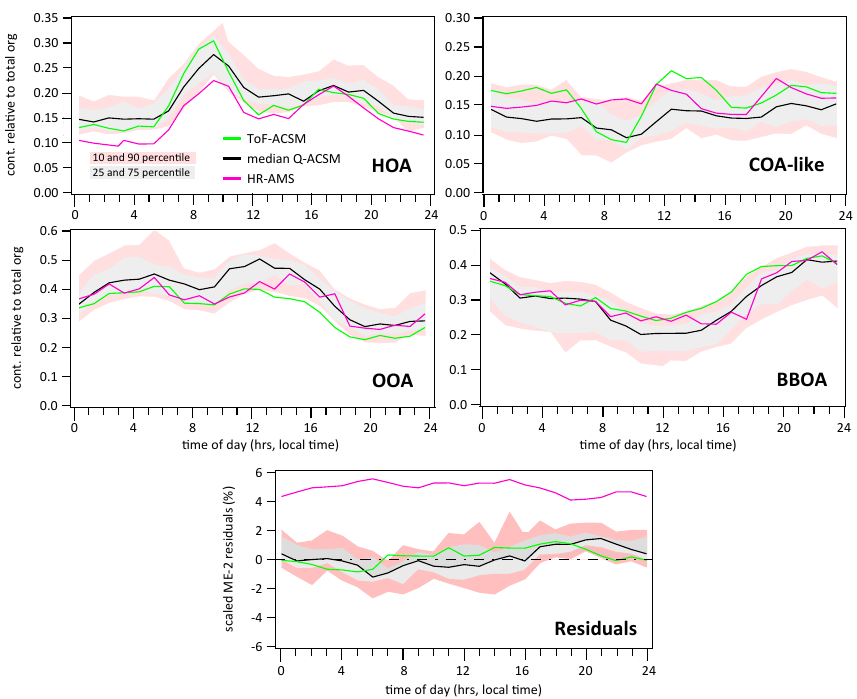
Figure 5. Diurnal variation of the four source factors and PMF residuals. The upper four panels display the relative contribution of the respective sources to the total apportioned organic matter. Top left: HOA, top right: COA-like, bottom left: OOA, bottom right: BBOA. Green trace: ToF-ACSM, pink trace: HR-ToF-AMS, black trace: median of all 13 Q-ACSMs. The IQR and the 10–90 percentile range of the Q-ACSMs are indicated as light grey and light red regions, respectively. The lower panel shows the residual organic concentration not explained by the presented solution in % of the total organic concentration. The time is local time (UTC + 1h). Hourly averages are displayed according to their time center (e.g. the data point at 12:30 represents the average between 12:00 and